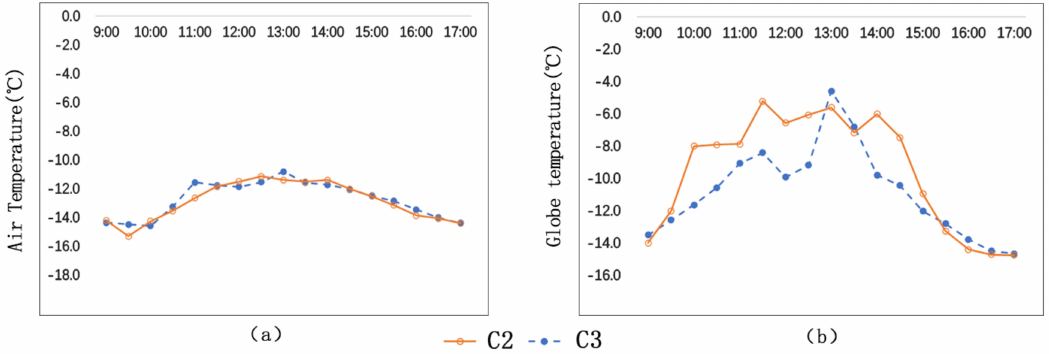
Figure 5. Comparison of air temperatures and globe temperatures of C2 and C3: ( a ) Ta; ( b )